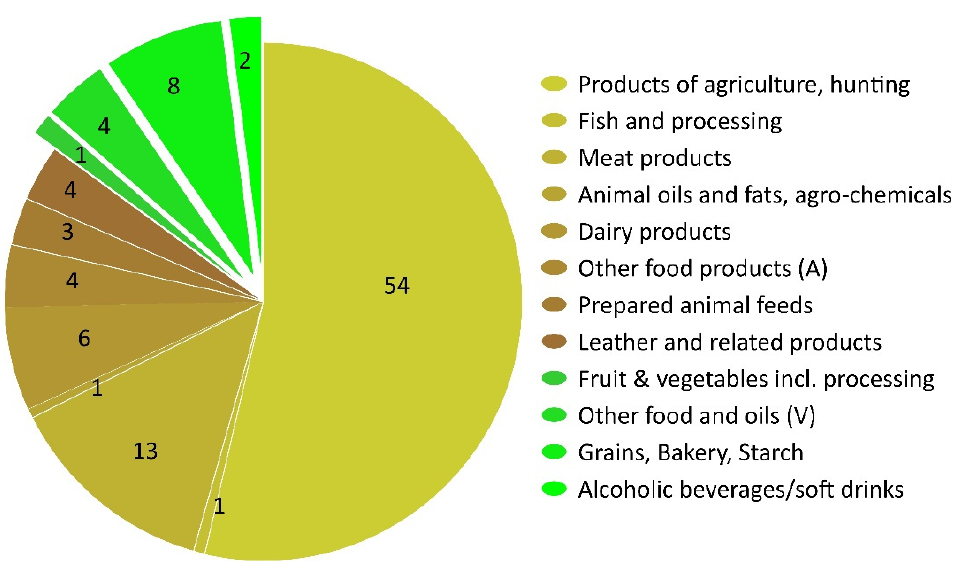
Figure 4. GHG emissions from food categories by UK consumption [42] allocated here to products derived from animals (brown shades) and other categories (green shades) as a percentage of food- related emissions (shown on each slice).